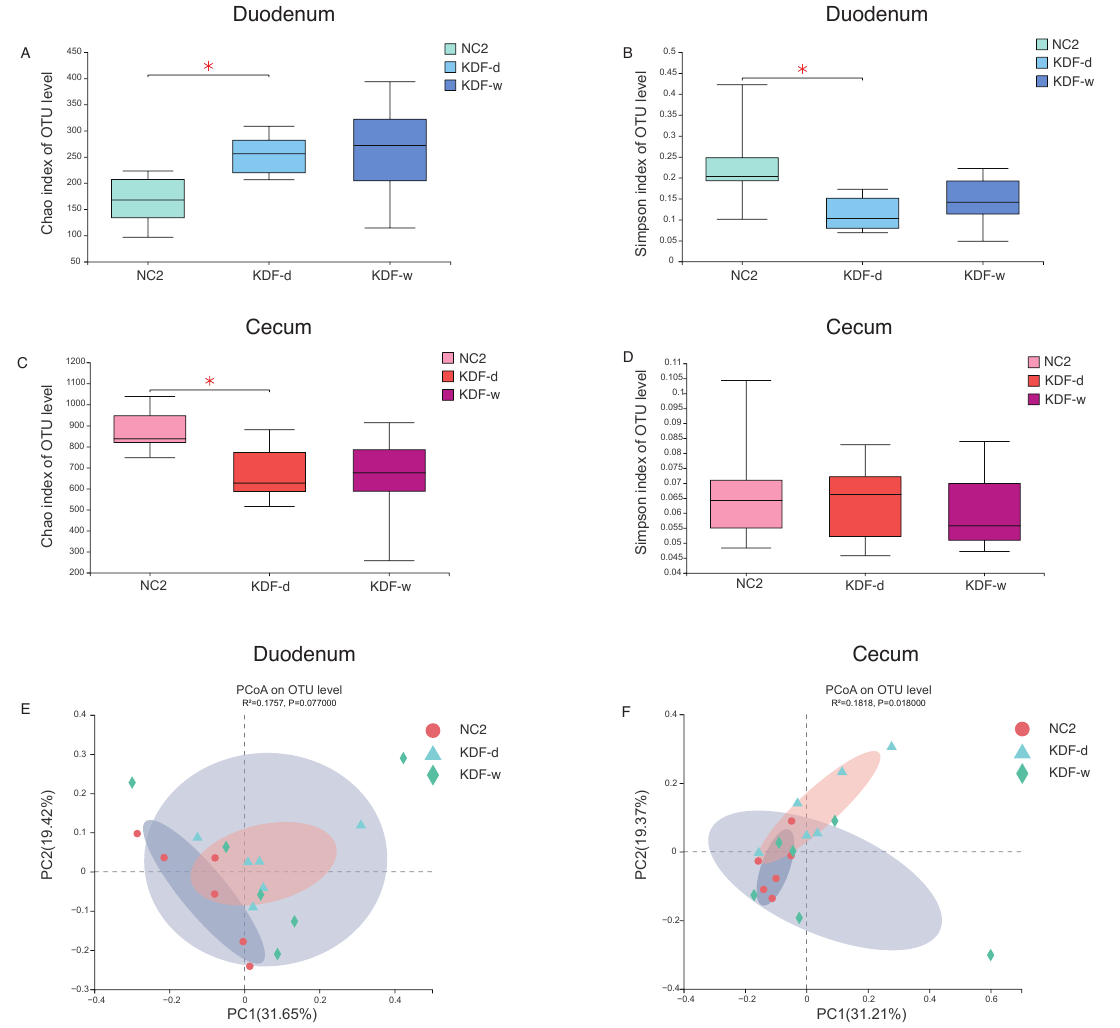
Figure 3. Gut microbial diversity in the investigated groups. Alpha diversity of the duodenum ( A , B ) and cecum ( C , D ) are determined by Chao1 index ( A , C ) and Simpson index ( B , D ), respectively. Beta diversity based on PCoA of the duodenum ( E ) and cecum ( F ) are also presented. NC2: chickens supplied with non-supplemented diet and water without infection (n = 6); KDF-d: chickens supplied with 0.5% KDF in diet without infection (n = 6); KDF-w: chickens supplied with 0.1% KDF in drinking water without infection (n = 6). * p <